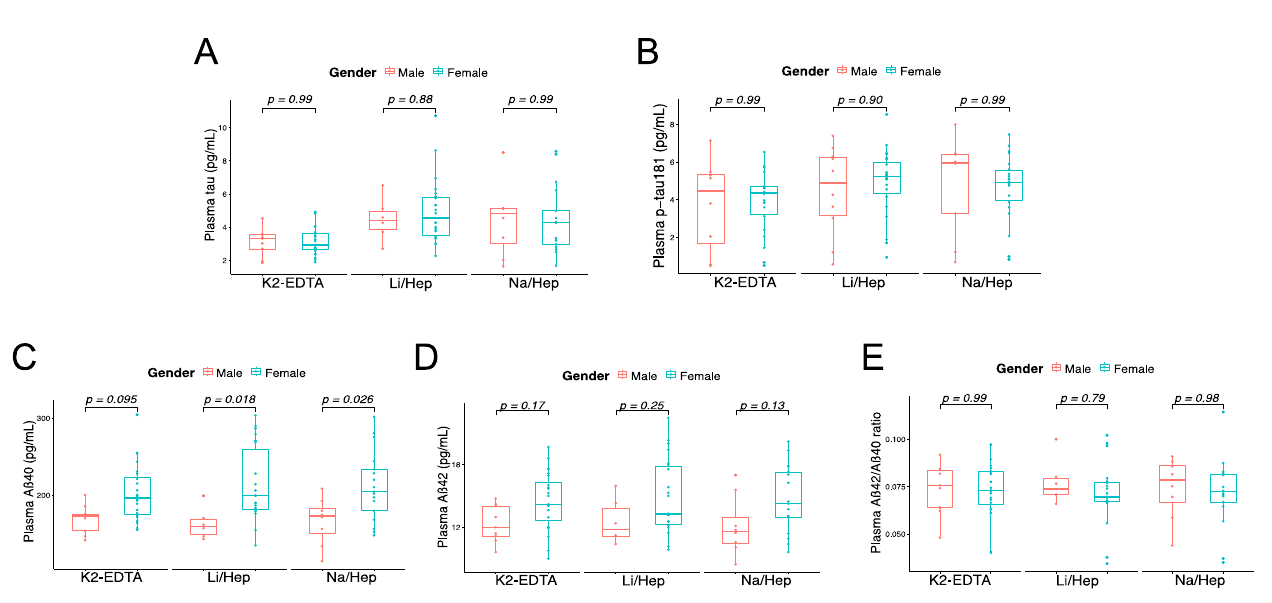
Figure 3. AD biomarkers comparison between genders among K2-EDTA, Li-Hep, and Na-Hep tubes, including tau ( A ), p-tau181 ( B ), A β 40 ( C ), A β 42 ( D ), and A β 42/40 ratio ( E ). The differences between groups were assessed by two-way ANOVA with Sidak multiple comparisons test. n was indicated in the methods and Table 1.